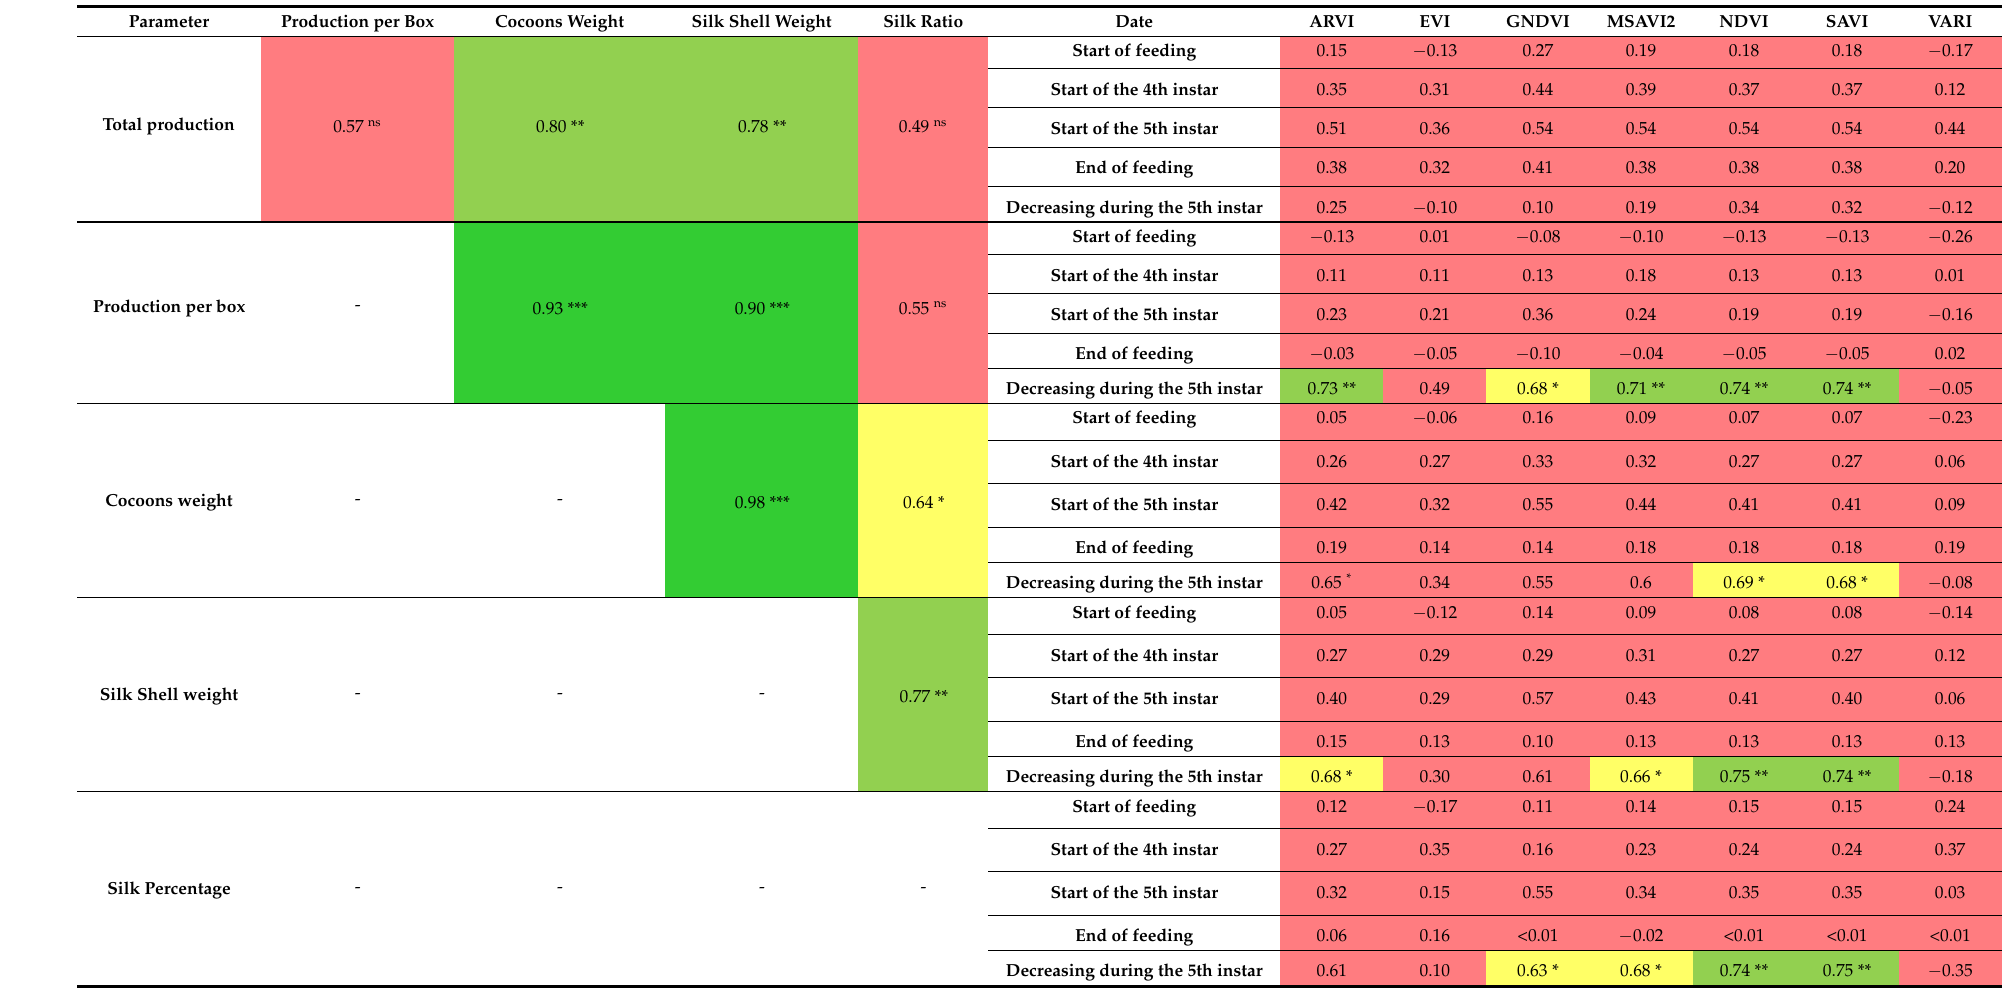
Table 6. Pearson’s correlation coefficients r describing correlations among vegetation indices and cocoon production